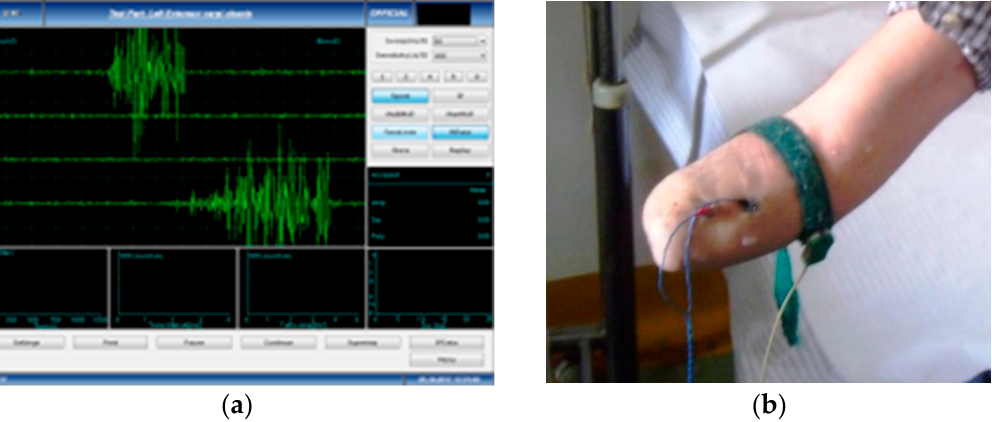
Figure 1. Harvesting the sEMG signals: ( a ) Dedicated software for accurate measuring; ( b ) Placement of the measuring electrodes, after correct skin preparation.